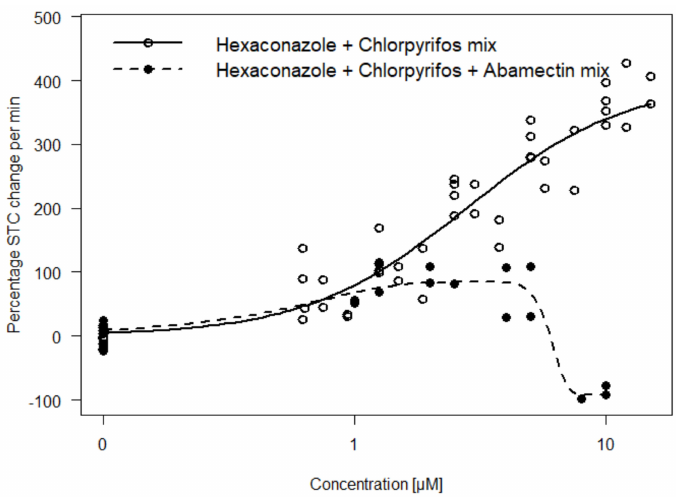
Figure 6. Comparison of concentration–response curves for hexaconazole and chlorpyrifos (Hy- peractive Mixture B) with or without the addition of abamectin. Addition of abamectin decreases the hyperactivity effect (i.e., indicating an antagonistic effect) observed for the mixture without abamectin. A gaussian function was fitted to the data to model the biphasic effect of the mixture with